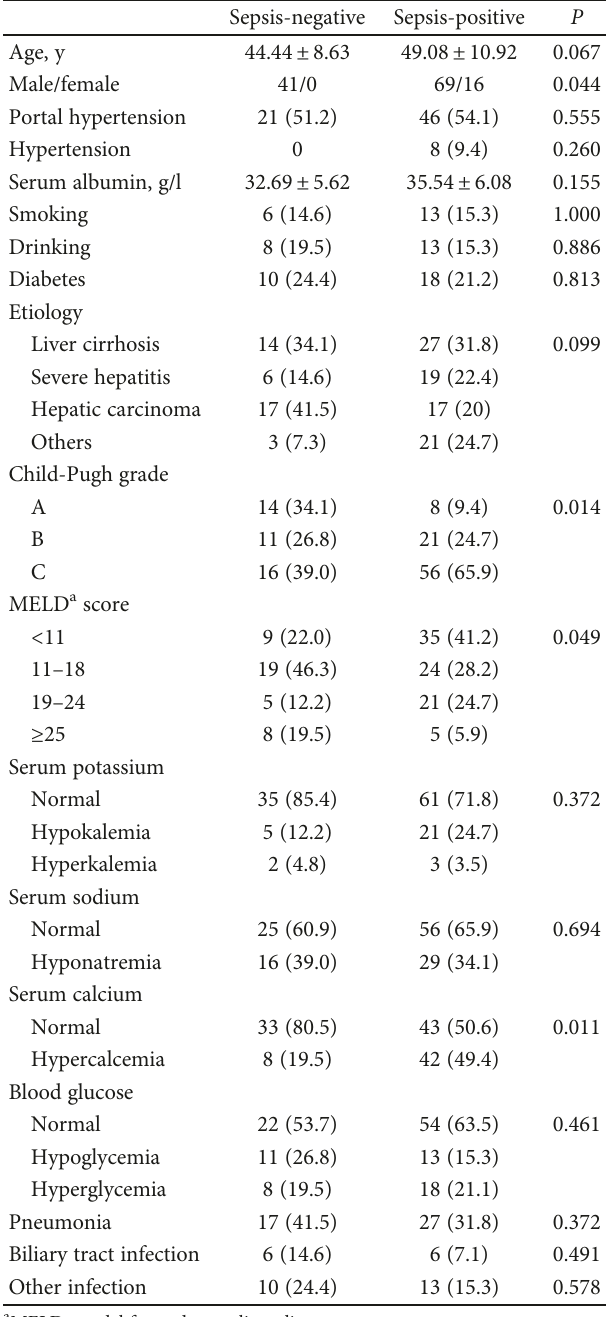
a MELD: model for end-stage liver